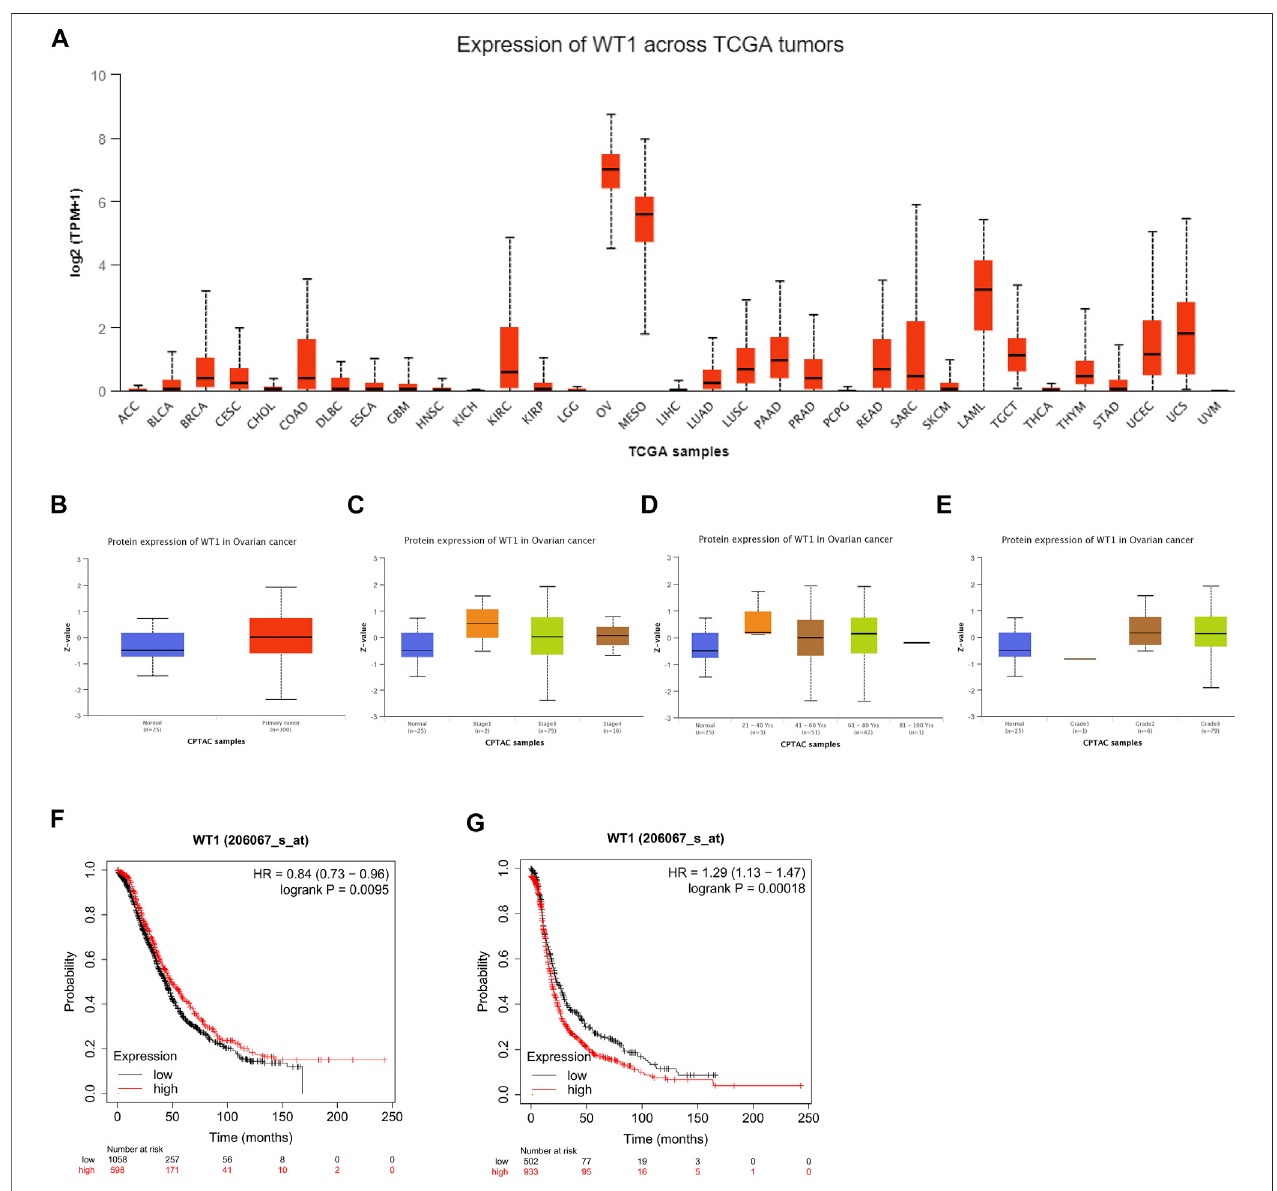
FIGURE 1 | Bioinformatics analysis of the clinical signi fi cance of WT1 in ovarian cancer (A) The expression level of WT1 mRNA in different cancers was analyzed through theUALCAN website. The expression of WT1 protein in ovarian cancertissuesand normal ovarian tissues (B) , ovarian cancersstrati fi ed bydifferent stages (C) , age (D) , and grades (E) were analyzed through the UALCAN website. Kaplan-Meier curves showing the correlation between the expression of WT1 and overall survival (F) and progression-free survival (G) of patients with ovarian cancer.